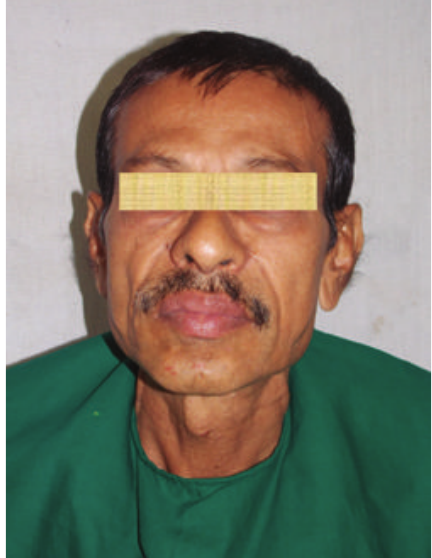
Figure 5: Picture after 4 months of antituberculous therapy, with completely resolved extraoral